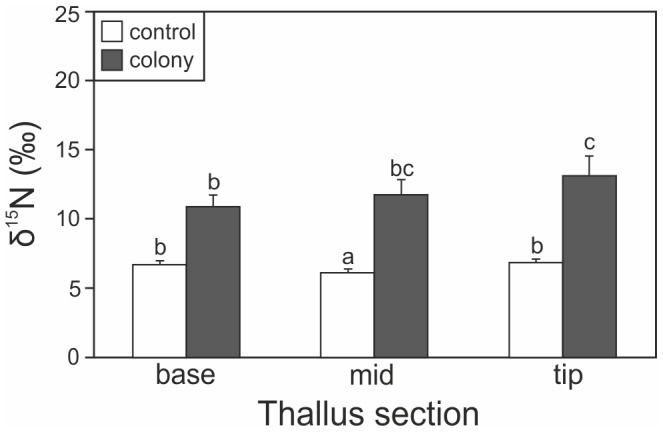
δ15N values (mean ± SE) of different sections of Fucus vesiculosus thalli from colony (black bars) and control (white bars) sites.Different letters indicate significantly different values within control or colony sites.